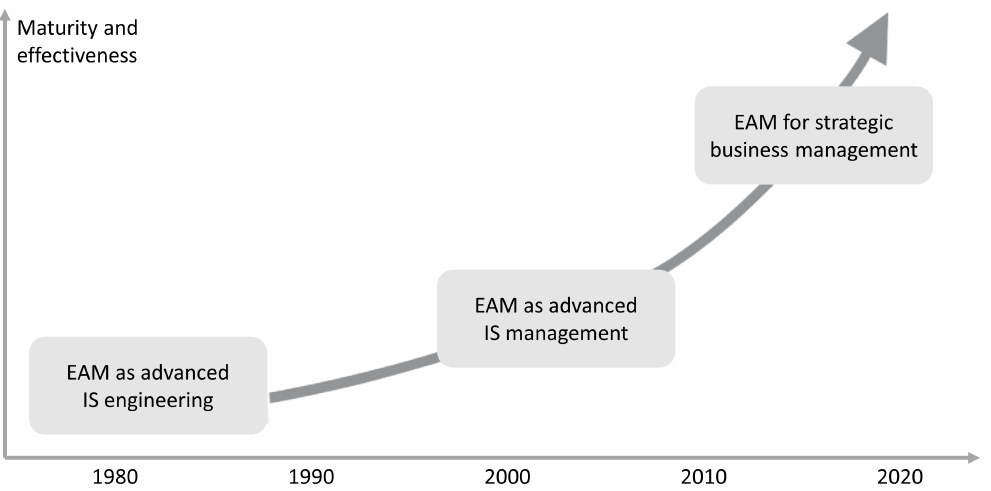
Figure 1. EAM development phases